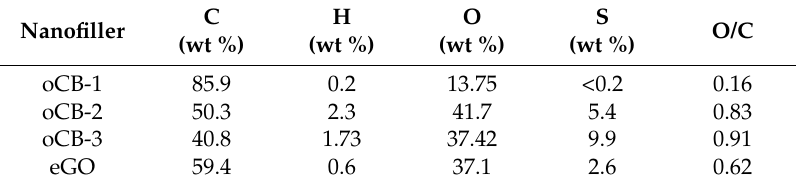
Table 1. Elemental analysis of the carbon-based nanofillers used in the study a . Nanofiller